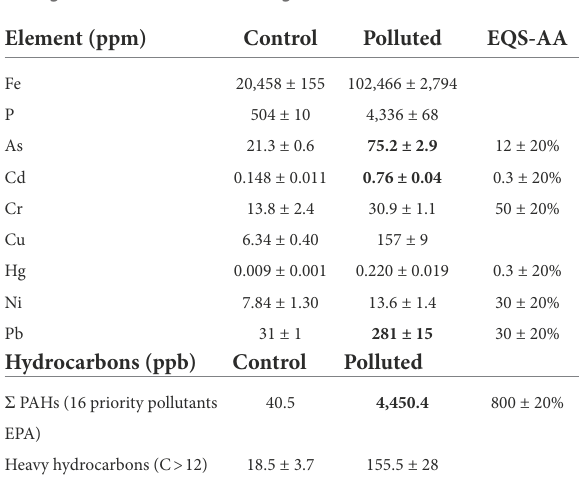
TABLE 2 Concentration of key elements and hydrocarbons in the sediment, and environmental quality standard expressed as an annual average values (EQS-AA) according to the IT law